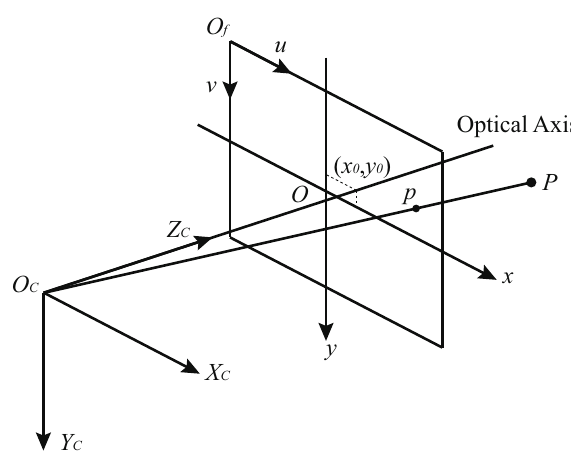
Figure 3. Accurate vision measurement camera